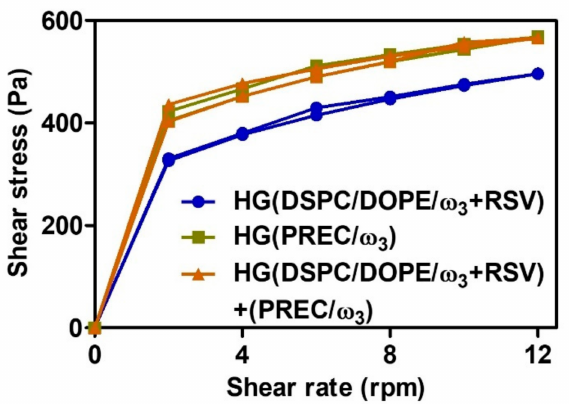
Figure 7. Rheograms of lipid nanosystems included in the hydrogel (HG). The data represent the means ± SD.